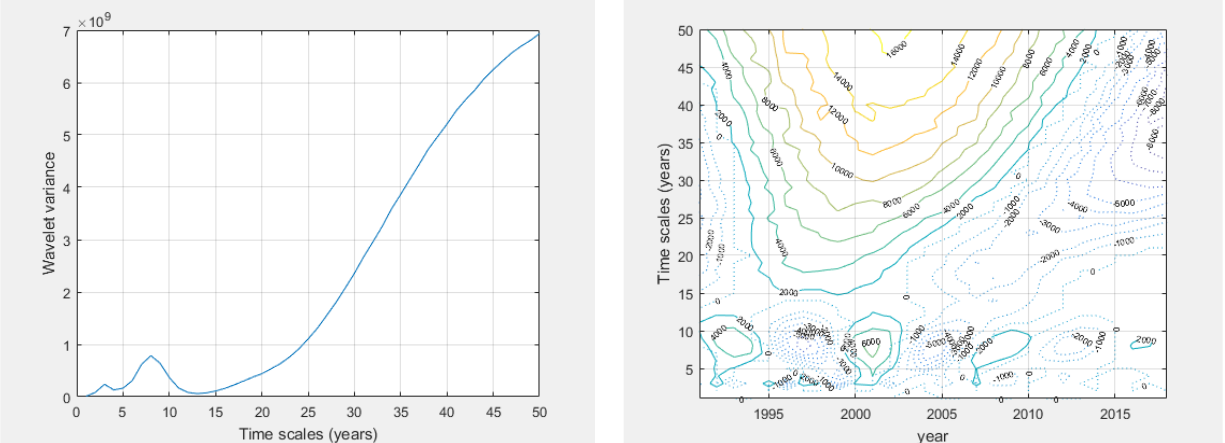
Figure 8. Wavelet square difference map and the real part contour map of the wavelet coefficients of the crop drought-affected area from 1991 to 2018.